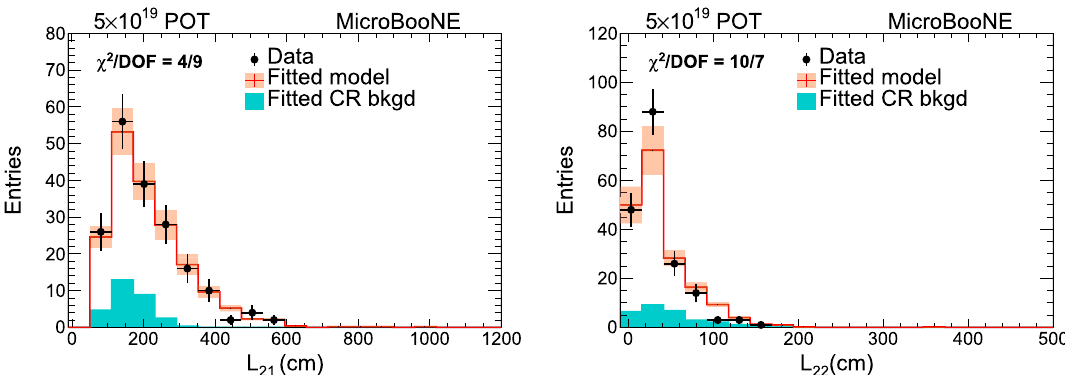
Fig. 17 Multiplicity = 2 track length distribution for candidate muon (left); for second track of the event (right) from neutrino-enriched sample for data and GENIE default MC